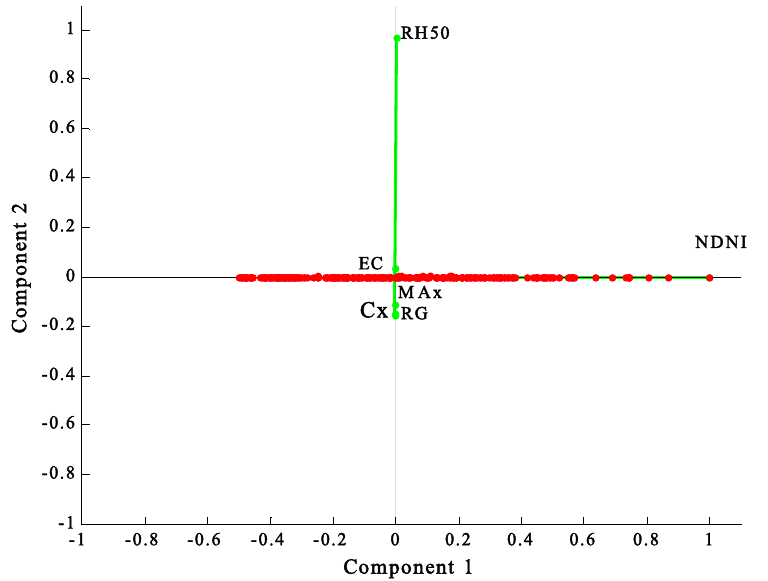
Figure 8. View of the fused feature data and the five metric variables (from both LVIS and HyMap data) in the space of the first two principal components.